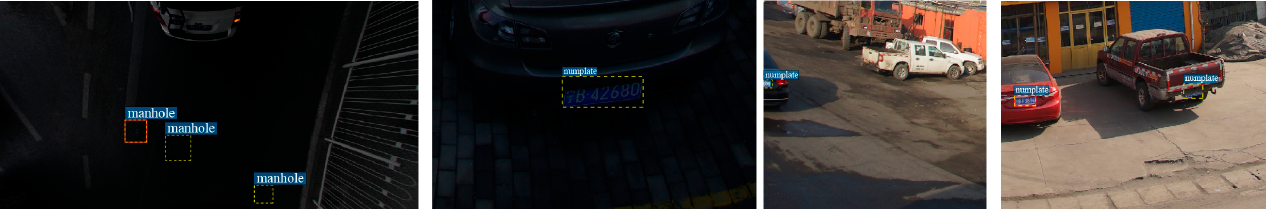
Figure 11. Typical failure cases. Red is the predicted bounding box and dashed yellow is the ground reference bounding box.